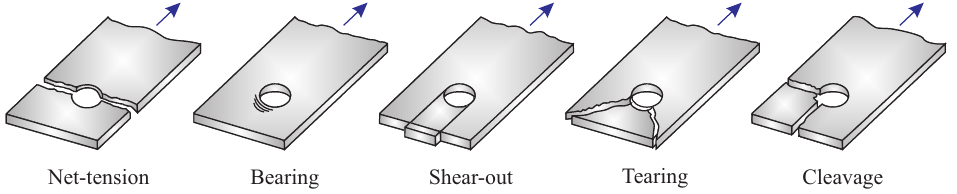
Figure 5. Schematics of different failure modes in bearing test.